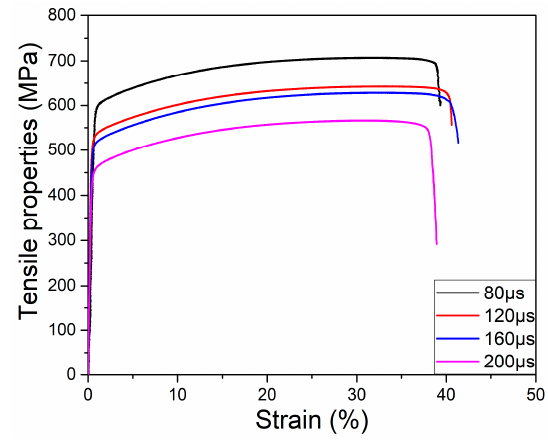
Figure 12. Tensile properties of samples with different exposure times of 80 μ s, 120 μ s, 160 μ s, and 200 μ s.